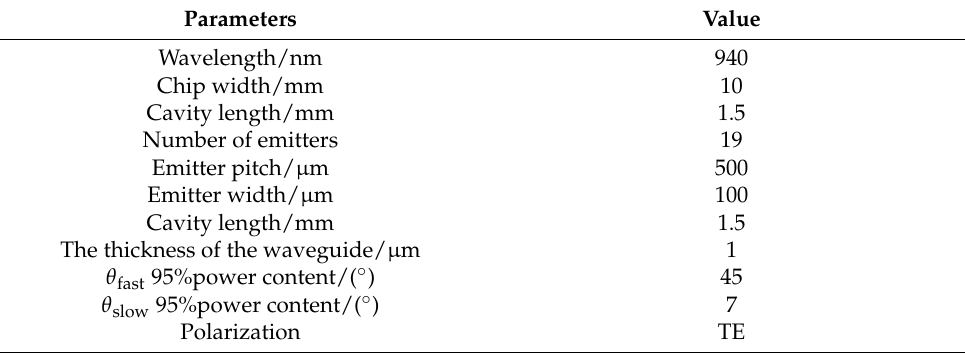
Figure 1. Setup for VSBC in the slow axis direction ( a ), VSBC in the fast axis direction ( b ) . A standard centimeter BAL bar with 19 emitters working at 940 nm is employed in our experimental setup. All the emitters are coated with a reflectivity of R < 5% on the front facet. The parameters of the diode laser array are shown in Table 1. The BTS and the FAC with focal lengths of 0.286 mm used are commercial products from LIMO. The SAC is a cylindrical lens with a focal length of 7 mm. The focal length of the transform lens is 350 mm. All optical components mentioned above have an anti-reflection coating of R < 0.5%. The diffraction grating is 1800 lines/mm with a first-order diffraction efficiency of 91% at 940 nm. From the measured result, we found that the grating brings a significant fraction of the loss about 10%. The HR mirror is a K9 mirror coated with Au. Table 1. The Parameters of the 940 nm Diode Laser Array .